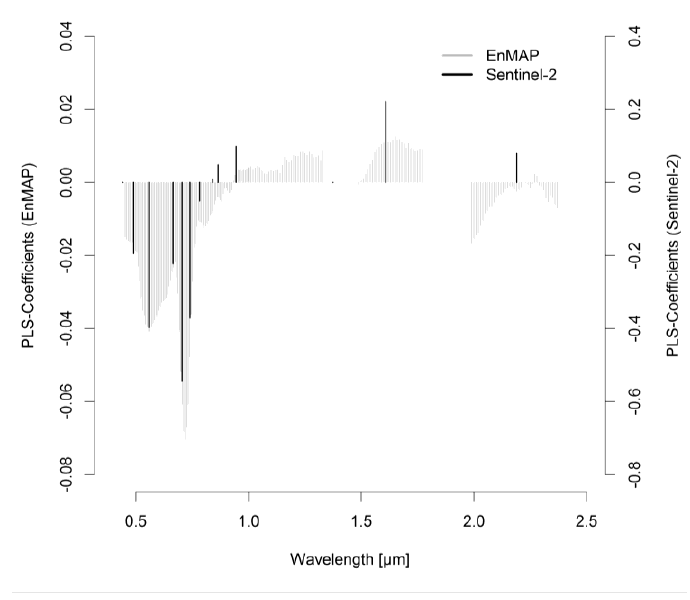
Figure 7. PLS regression coefficients for all EnMAP and Sentinel-2 spectral bands.